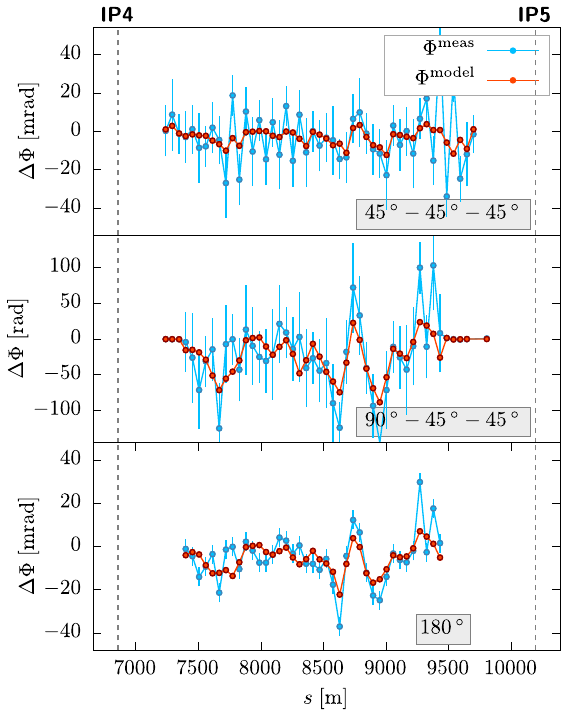
FIG. 8. The local observable with the error distribution of Table II, including a strong error source at MQ.22R4.B1 and phase noise of 0 . 7 × 10 − 3 × 2 π rad. The position of the strong error source is marked by a green